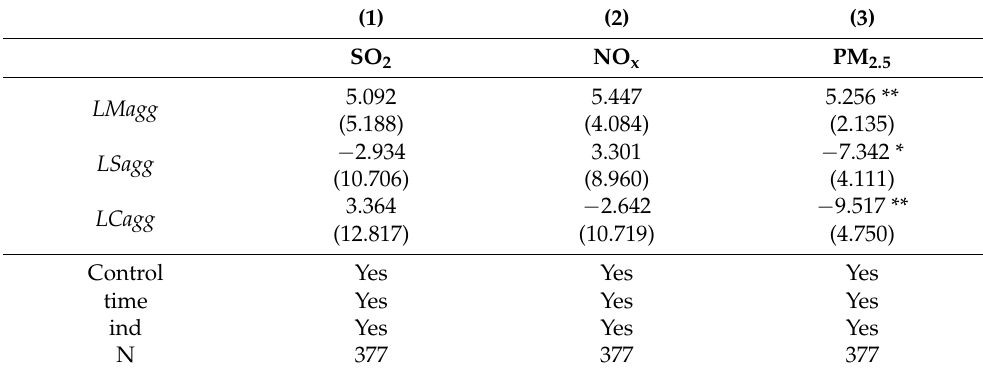
Table 8. First-phase lag test of the effect of industrial agglomeration on air